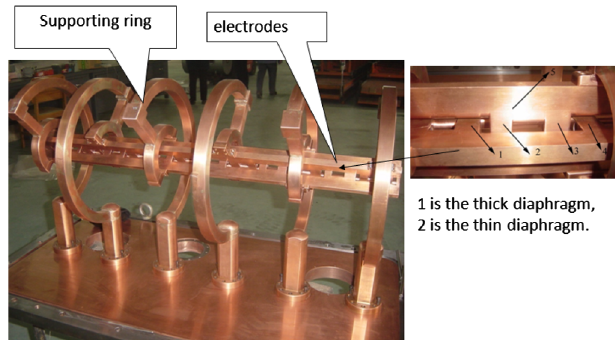
FIG. 6. SFRFQ structure with diaphragms loading on quadru- pole poles.